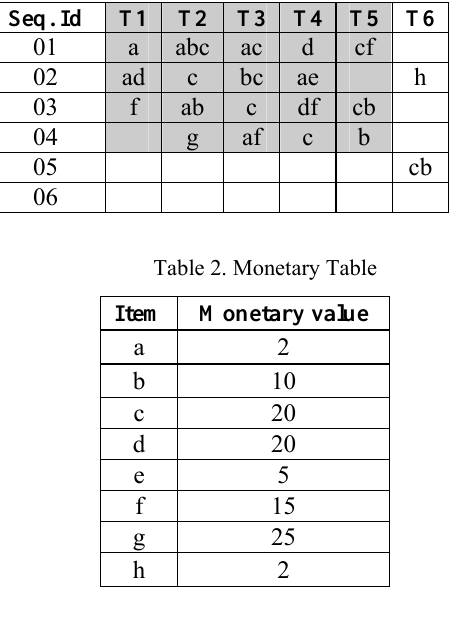
Table 3. Mined CFM-Sequential Patterns CFM-Sequential